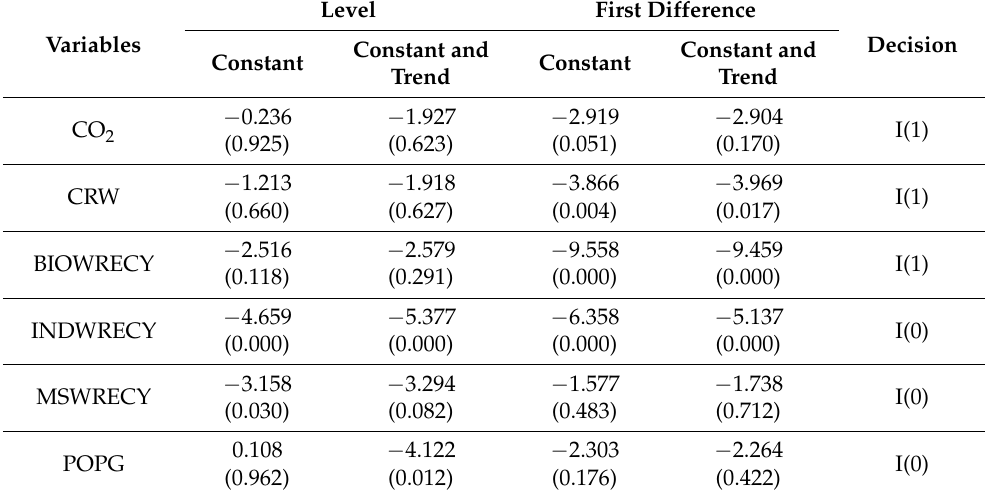
Table 4. ADF Unit Root